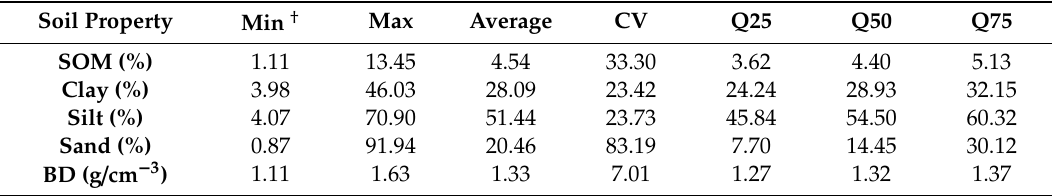
Table 1. Summary statistic of basic soil properties for the watershed in Northern Great Plains of USA. Soil